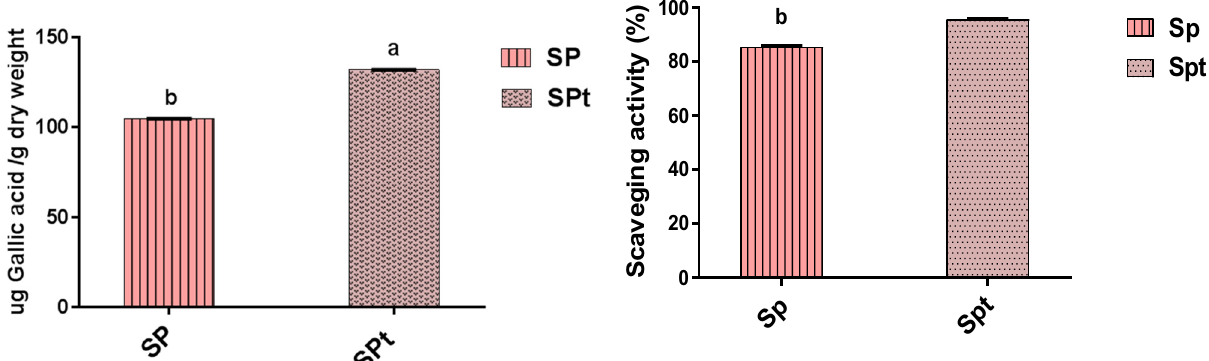
Figure 1: Total phenolic contents of methanolic extracts of SP and SP supplemented with thiamine for 21 days of culture. Di ff erent letters mean signi fi cant change between groups ( p < 0.05 ) .